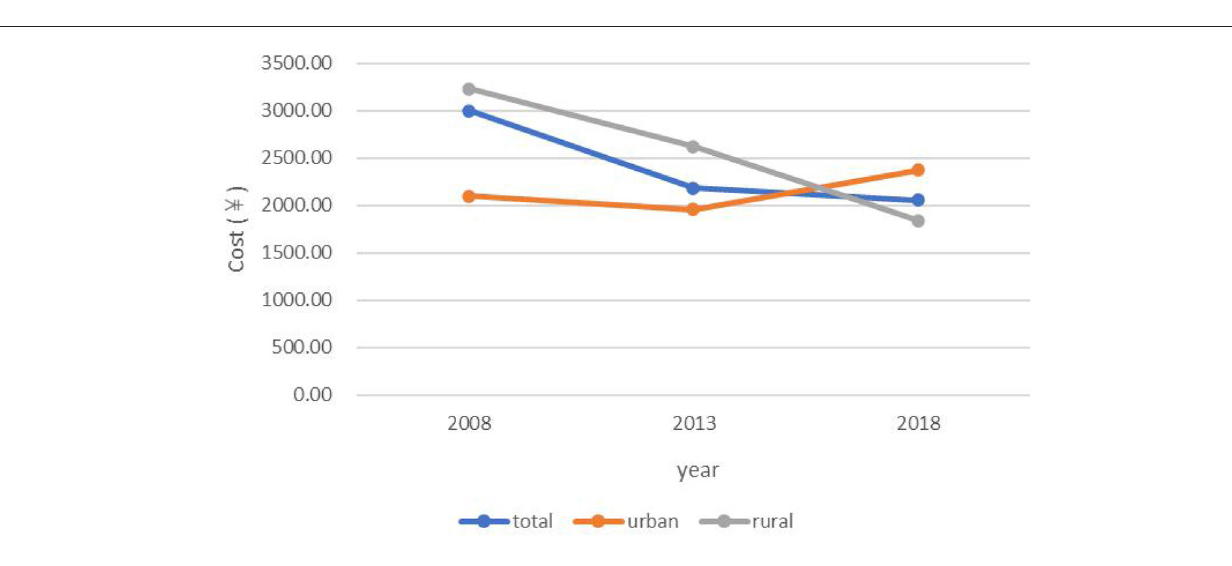
FIGURE 4 | Trends in annual OOP among residents of urban and rural areas from 2008 to